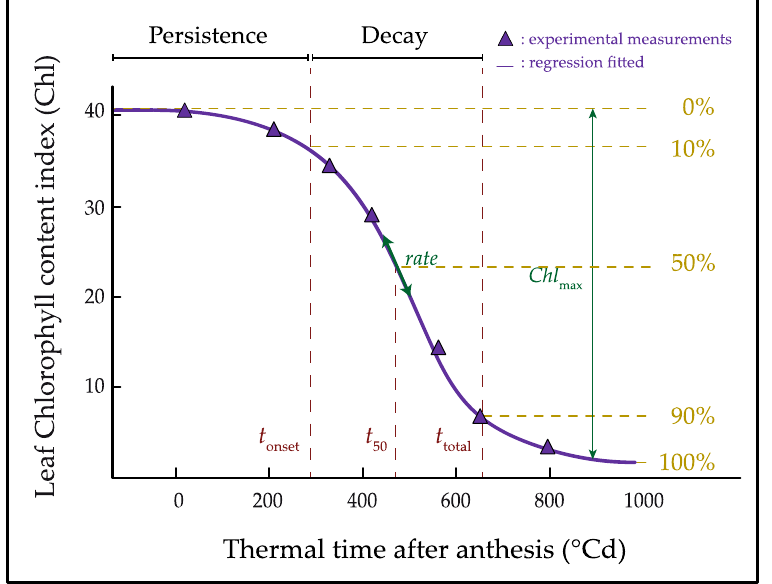
Figure 6. Graphical representation of the logistic function fitted for flag leaf senescence and the estimated stay-green traits. Total duration of leaf senescence ( t total ) is defined as the period from anthesis to the time when 90% of chlorophyll content has been lost (90% senescence). The t total is divided in two phases: the chlorophyll persistence phase, from anthesis to the time when reach 10% senescence ( t onset ), and the decay phase ( decay ) from t onset to t total . Rate indicates the rate of chlorophyll loss, Chl max correspond to the maximum chlorophyll content, and t 50 indicate the time when reach the maximum senescence rate.